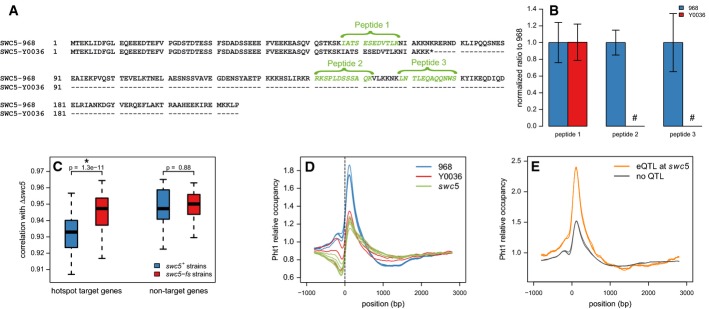
swc5 frameshift as molecular basis of the Chromosome III hotspotSequence of Swc5 in the 968 and Y0036 genetic backgrounds, the latter containing the frameshift
polymorphism swc5-fs.Average ratios and standard deviations for all three peptides determined from three independent
replicates of strains 968 and Y0036. MS signals with signal-to-noise ratios of < 3 are not
considered (#). Error bars indicate standard deviation. The peptides located after the frameshift
could not be detected.Pearson's product-moment correlation coefficient of expression patterns between
Δswc5 and swc5-Y0036 (frameshift polymorphism;
swc5-fs) and swc5-968 (wild-type;
swc5+) strains. For genes linked to the swc5
locus (hotspot targets; 871 genes), expression in Δswc5 was significantly
more correlated with swc5-fs segregants (red) than with
swc5+ segregants (blue) (*P = 1.3
× 10−11, Wilcoxon's signed-rank test). For genes not linked to the
swc5 locus (non-targets; 5,593 genes), there was no difference in correlation.
Thus, the swc5 deletion mimics the expression signature of the Y0036 allele at this
locus.Average Pht1 (H2A.Z) occupancy at the 5′-ends of all coding genes in the parental strains
of the recombinant yeast library. Genes were aligned at the transcription start site. Pht1 peaks at
the +1 nucleosome after the transcription start site. There is significantly less Pht1 at the
+1 nucleosome in Y0036 than in the 968 background (P <
10−15, one-sided Wilcoxon's signed-rank test, n =
5,016).Comparative average Pht1 occupancy in 968 (scw5+) of the genes
linked (orange, n = 602) and not linked (gray, n =
4,504) to the swc5 locus. There is significantly more Pht1 at the +1
nucleosome in genes associated with the swc5 QTL than in others (P
< 10−15, one-sided Wilcoxon's rank-sum test).